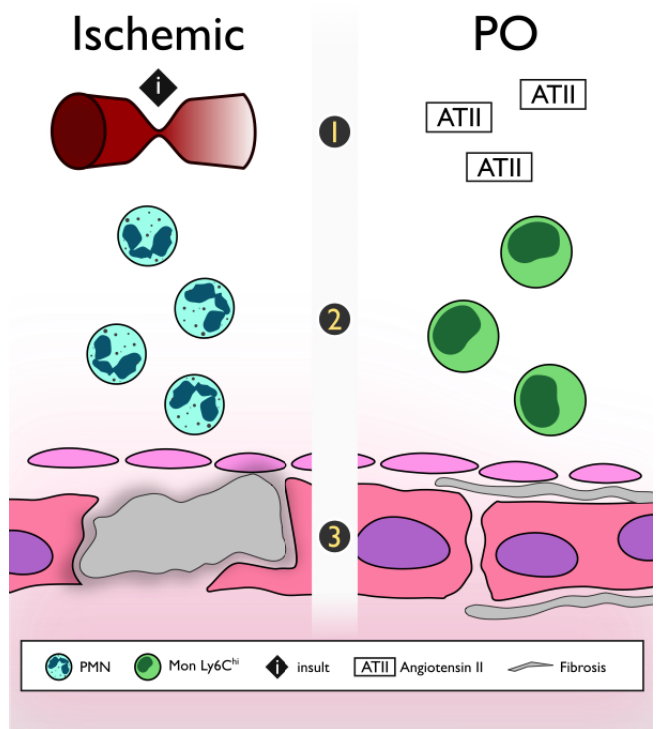
Figure 1. Key differences between the ischemic and PO-HF murine model. ( 1 ) Type of insult, ( 2 ) First to arrive: type of cellular infiltrate, and ( 3 ) type of fibrosis. Mon Ly6C hi : inflammatory monocytes; PMN: Polymorphonuclear neutrophils; PO: Pressure overload.